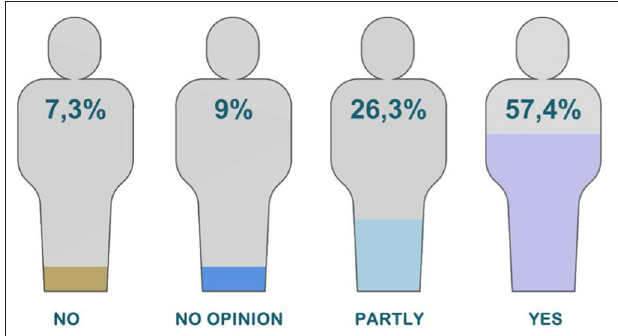
FIGURE 4 | Percentage of professional establishment of participants.